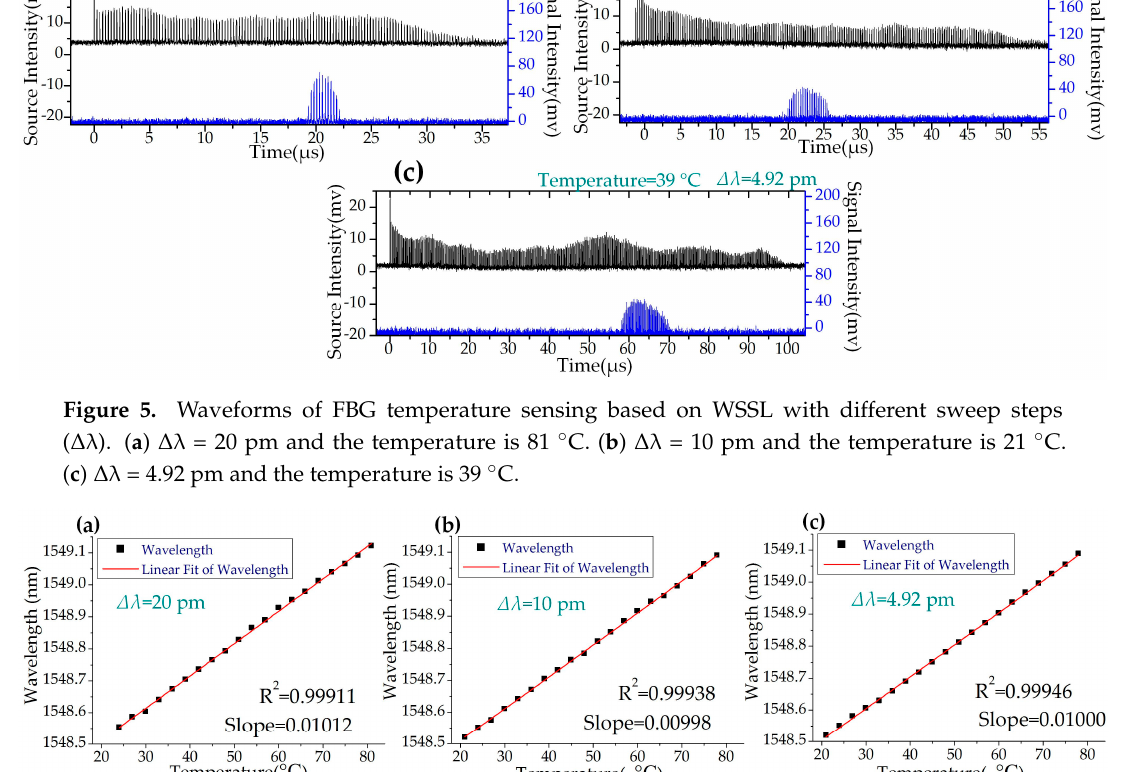
Figure 6. Interrogating results of FBG temperature sensing. ( a ) ∆λ = 20 pm. ( b ) ∆λ = 10 pm. ( c ) ∆λ = 4.92 pm.